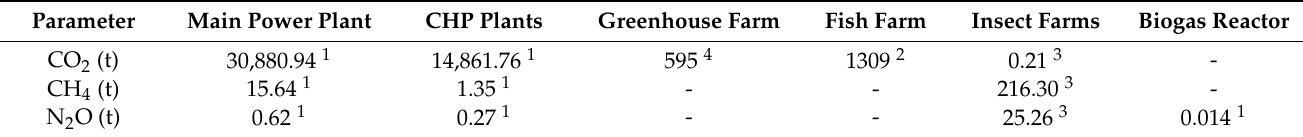
Table 5. Yearly environmental impact of businesses.